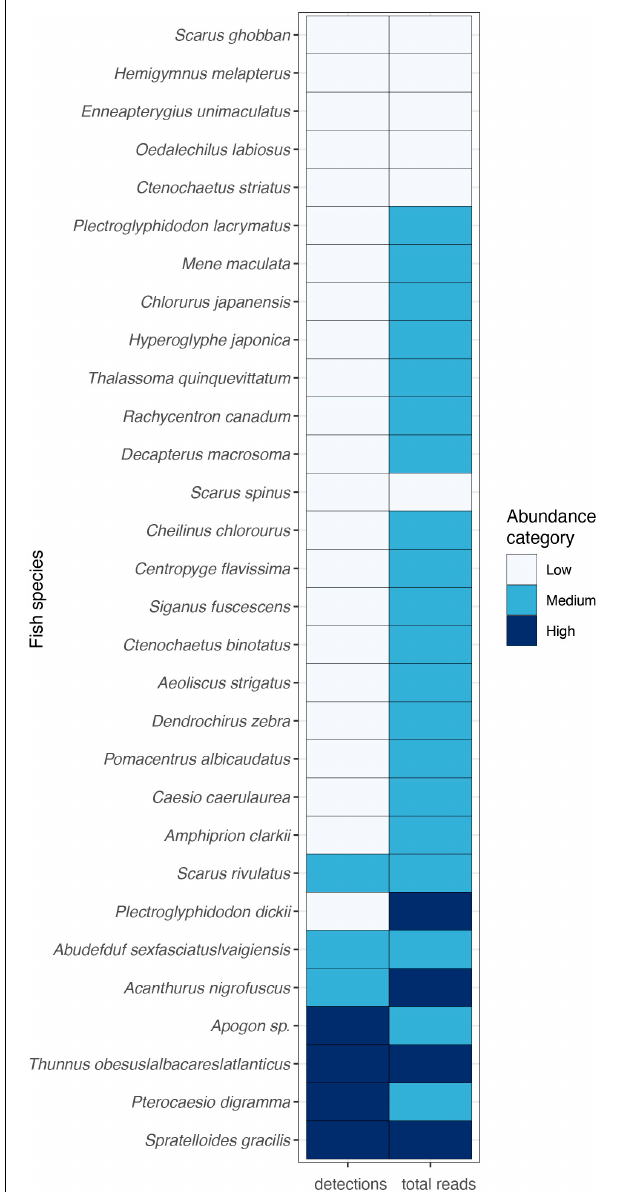
FIGURE 6 | The most abundant fish species recovered from sponge nsDNA in Nha Trang Bay. The abundance categories correspond to number of total detections and number of total reads (log transformed) classified as: high ( > 10), medium (5–10), and low (2–5). Only MOTUs detected at least twice are